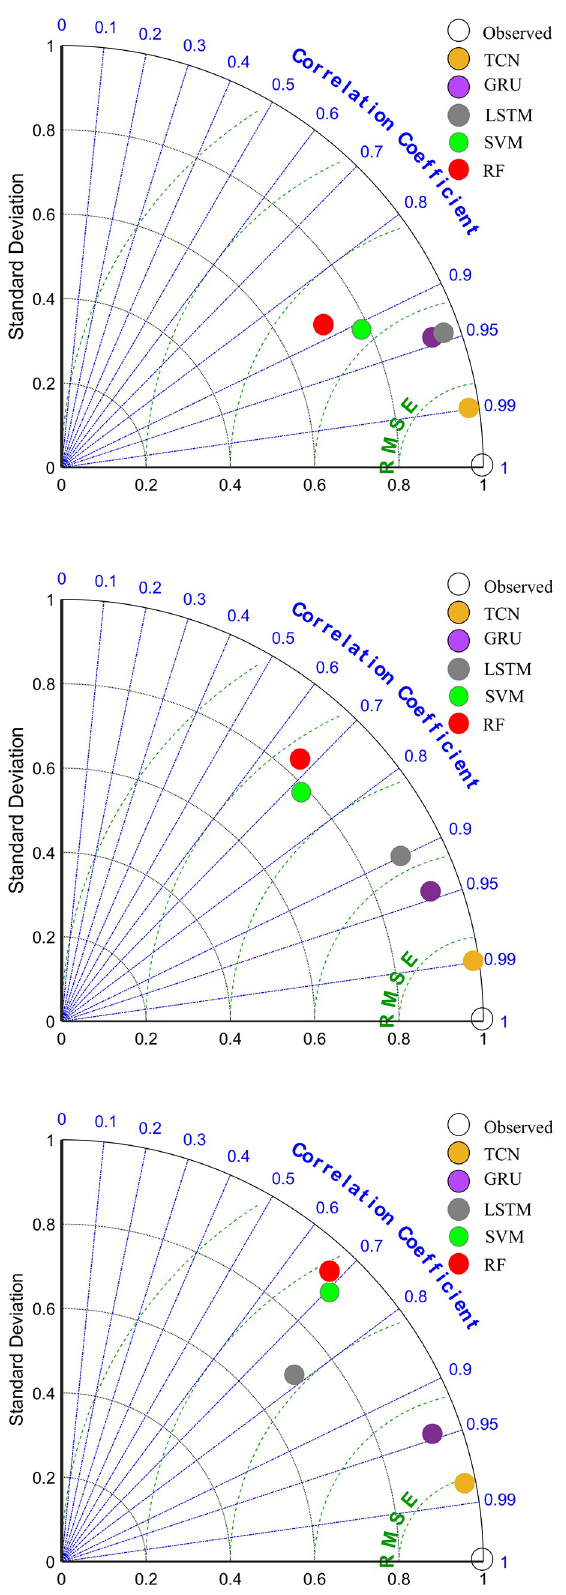
Fig 9. Normalized Taylor diagrams. (a) Future 12-hour prediction. (b) Future 24-hour prediction. (c) Future 48-hour prediction. https://doi.org/10.1371/journal.pone.0254179.g009 PLOS ONE | https://doi.org/10.1371/journal.pone.0254179 July 23,